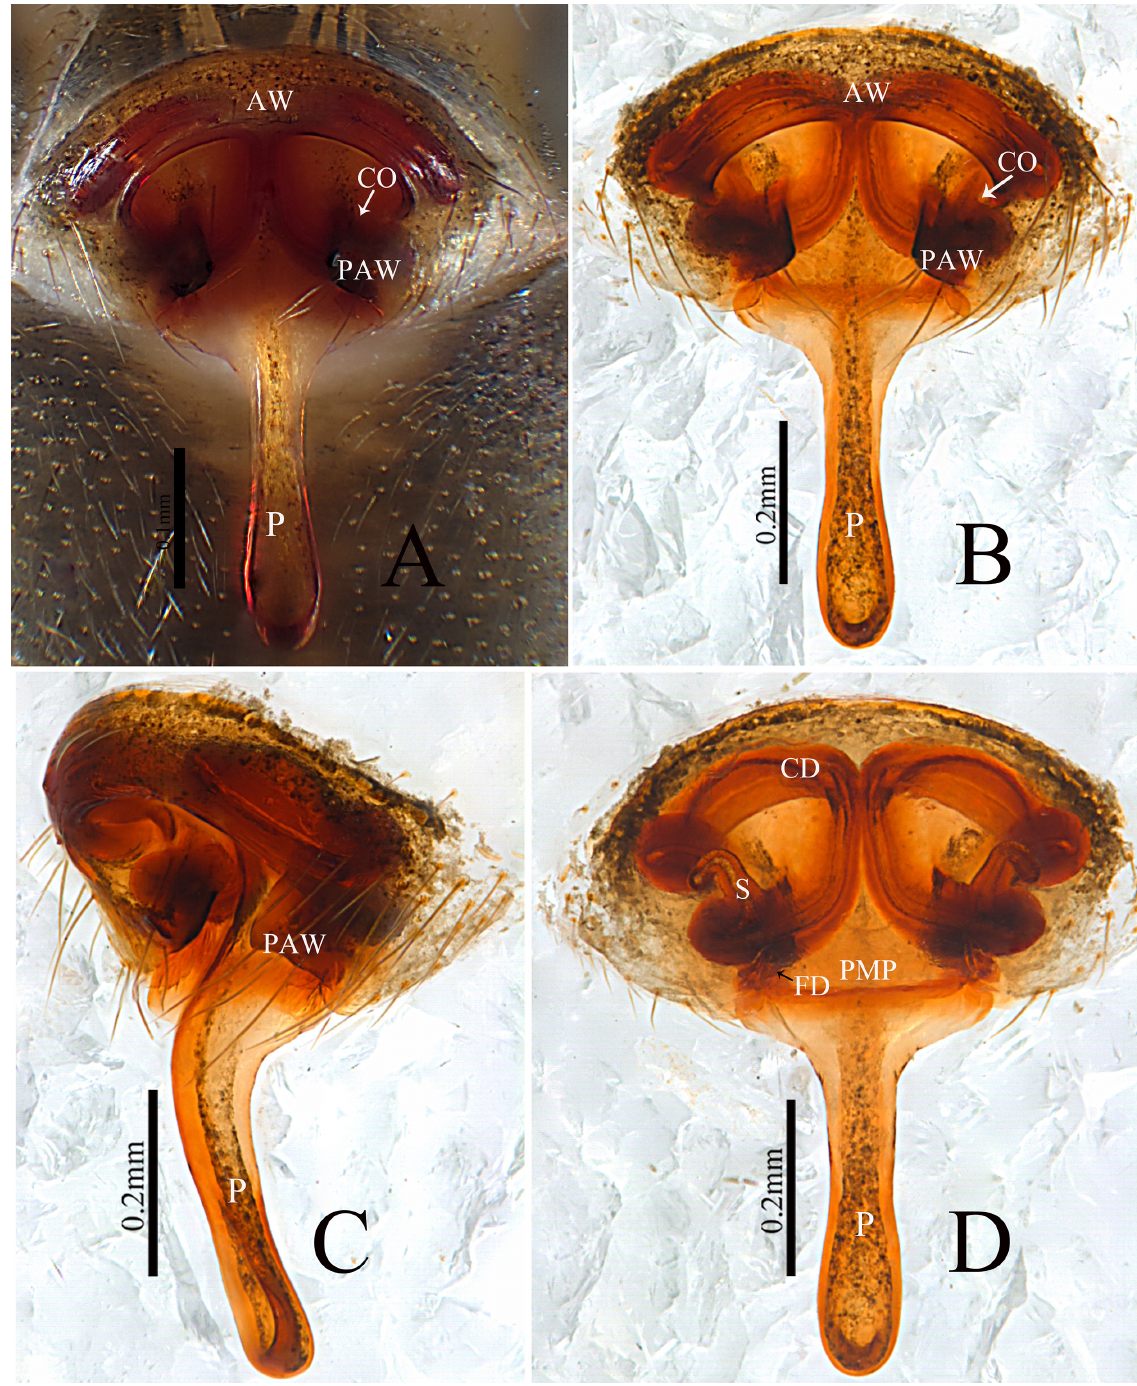
Fig. 19. Acroterius hamatus gen. et sp. nov., ♀, holotype (HNU-Tang–04–04). A–B . Epigyne, ventral view. C . Epigyne, lateral view. D . Vulva,